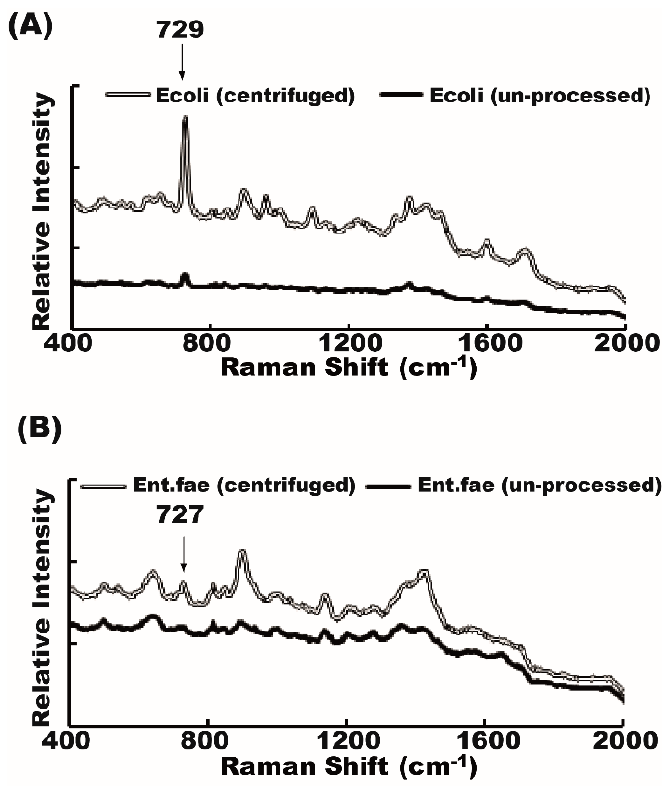
Figure 2. Raman shift patterns of bacteria from the unprocessed and centrifuged Raman. Raman spectrum of urine bacteria from the unprocessed sample (black line) and centrifuged sample (empty line) are similar. ( A ) Escherichia coli ; ( B ) Enterococcus faecalis .